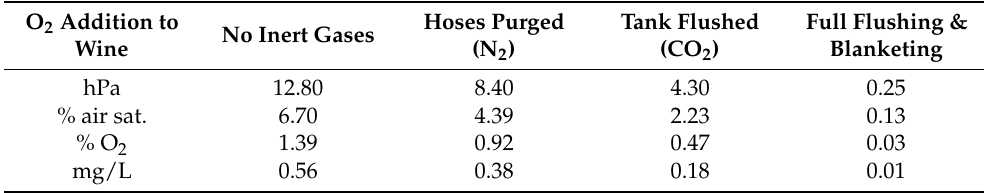
Figure 8. Evolution of the level of dissolved oxygen in wine after tank-to-tank racking with both tank intakes at the bottom and using different intensities of inert gases. Table 8. Oxygenation caused in the racking according to the different levels of inertization